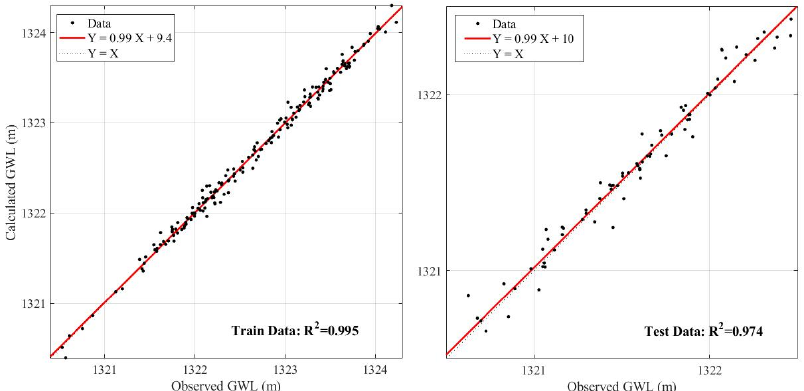
Figure 8. Regression plots of Wavelet-ANFIS (Sym4 mother wavelet)-simulated over observed GWL-data for training (left panel) and testing (right) phases.